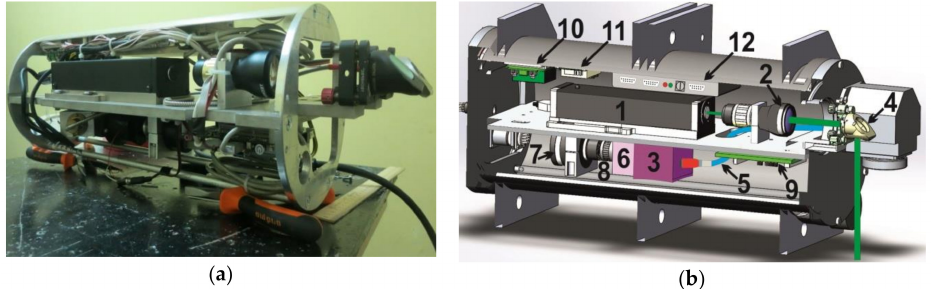
Figure 2. ( a ) Submersible module of the LIF sensor; ( b ) Setup scheme of the submersible module of the LIF device: 1—laser; 2—collimator; 3—spectrometer; 4—rotary mirror of the output radiation; 5—optical multi-core fiber; 6—electro-optical converter; 7—CCD camera Videoscan-285 USB;